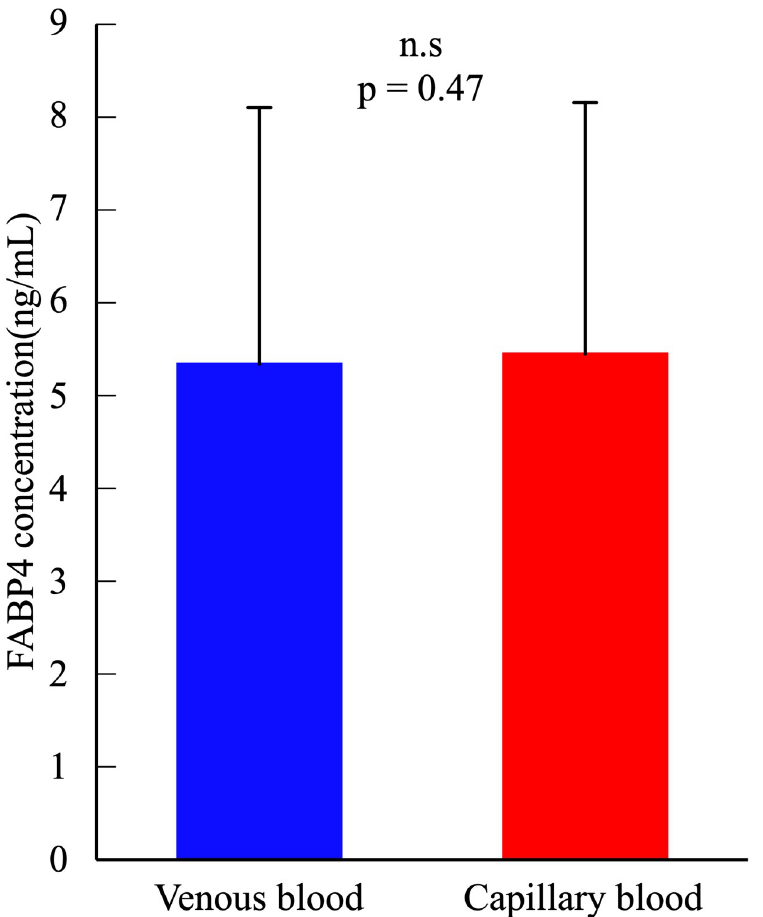
Fig 1. Difference in plasma FABP4 concentration between venous and capillary blood. Data are presented as the mean ± SD. There was no significant difference in plasma FABP4 concentration between venous and capillary blood ( p =